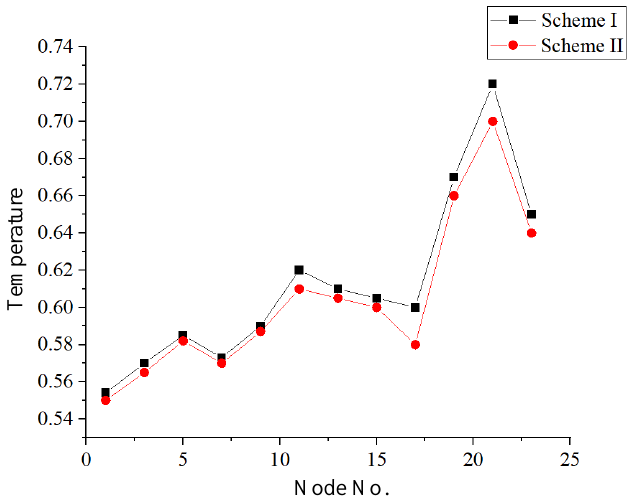
Figure 37. Temperature calculation results of blade specific